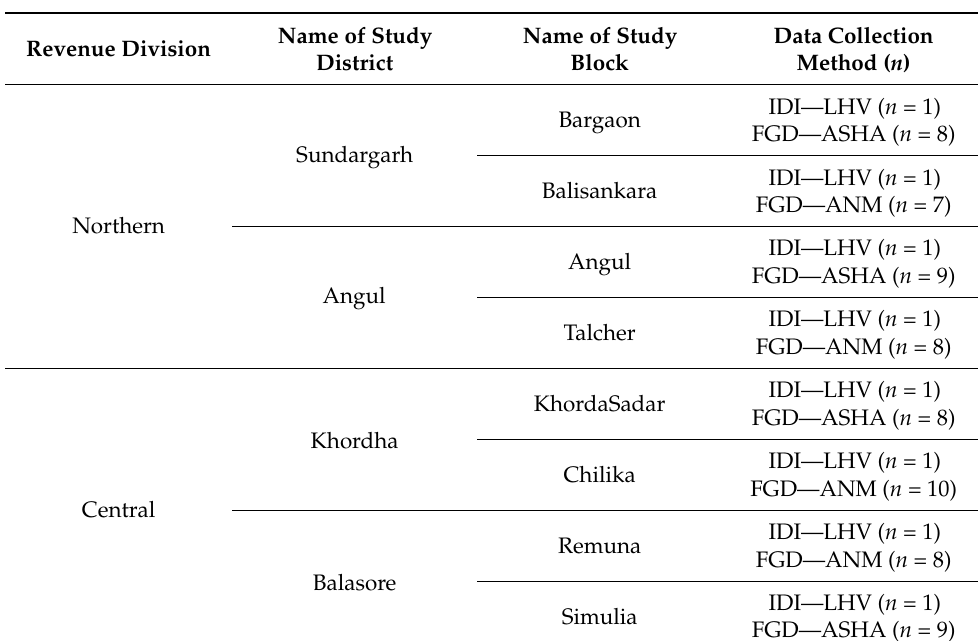
Figure 1. Map of Odisha and the division-wise study districts and blocks. Table 1. Detailed descriptions of study sites and participants.